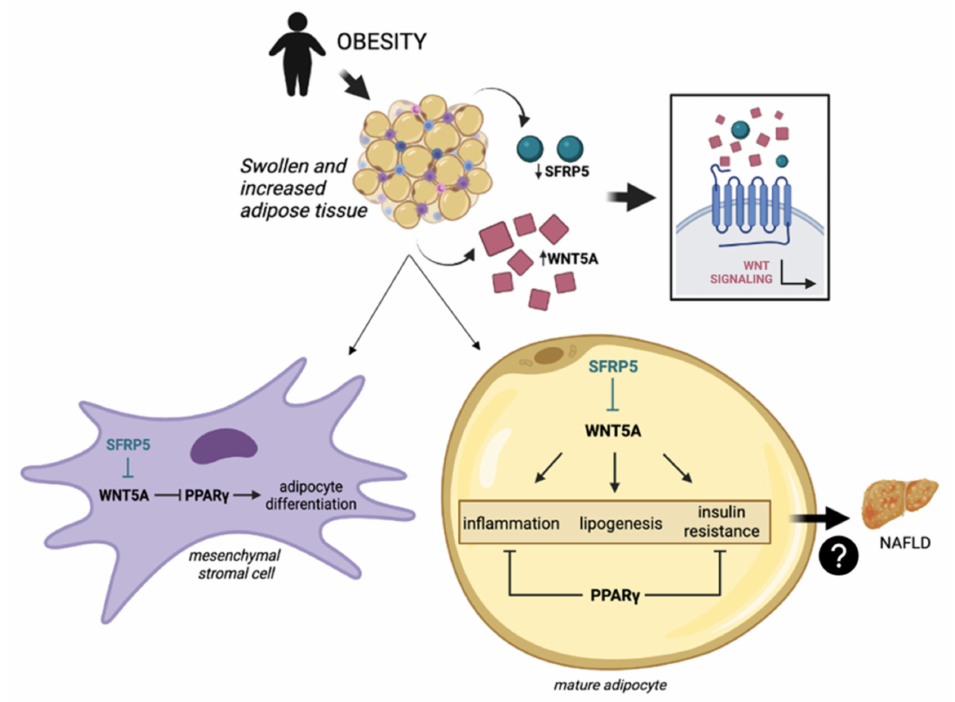
Figure 1. Obesity, the main comorbidity of NAFLD [2,5,6], causes chronic low-grade inflammation of the adipose tissue, leading to an upregulation of WNT5A [27,28] and a decrease in SFRP5 [26]. In mesenchymal stromal cells, WNT5A inhibits the adipogenesis by blocking PPAR γ [21]. In ma- ture adipocytes, WNT5A triggers an inflammatory response, lipogenic outcomes and insulin re- sistance [23,29,30], while PPAR γ exhibits anti-inflammatory properties and acts as an insulin sen- sitizer [31,32]. These signs of metabolic breakdown could negatively affect the liver, making it susceptible to NAFLD occurrence [33,34]. NAFLD, nonalcoholic fatty liver disease; SFRP5, secreted frizzled-related protein 5; WNT, wingless-MMTV integration site; WNT5A, WNT family member 5a; PPAR γ , peroxisome proliferator-activated receptor